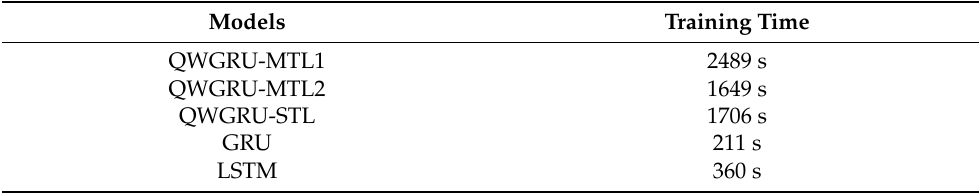
Table 5. The time required for training of five